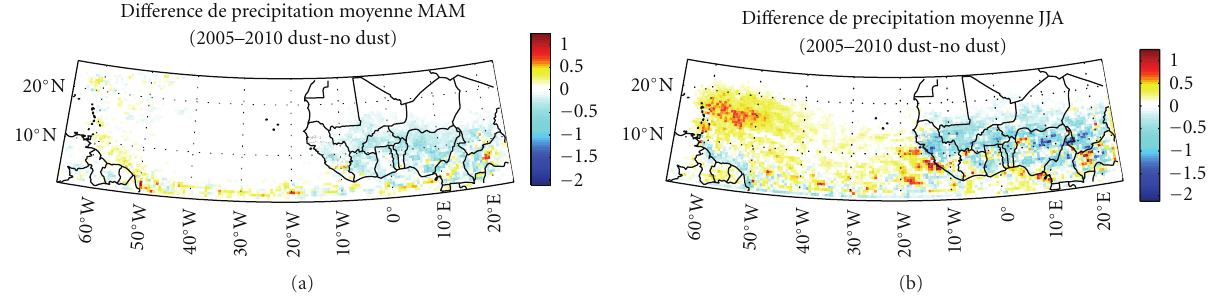
Figure 15: E ff ect of dusts on precipitations in mm/day during the period of MAM and JJA. Precipitation decrease is indicated with cool colors while increase in precipitation with hot